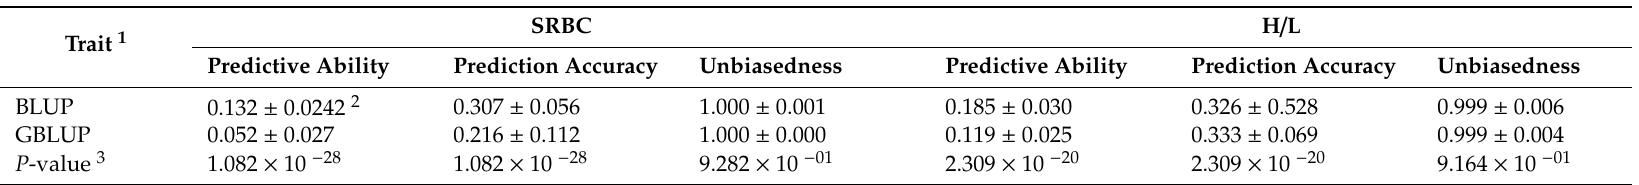
Table 4. The accuracy of prediction for sheep red blood cells (SRBC) and heterophils to lymphocytes (H / L) traits in 50 time 5-fold cross-validation (CV). Trait 1